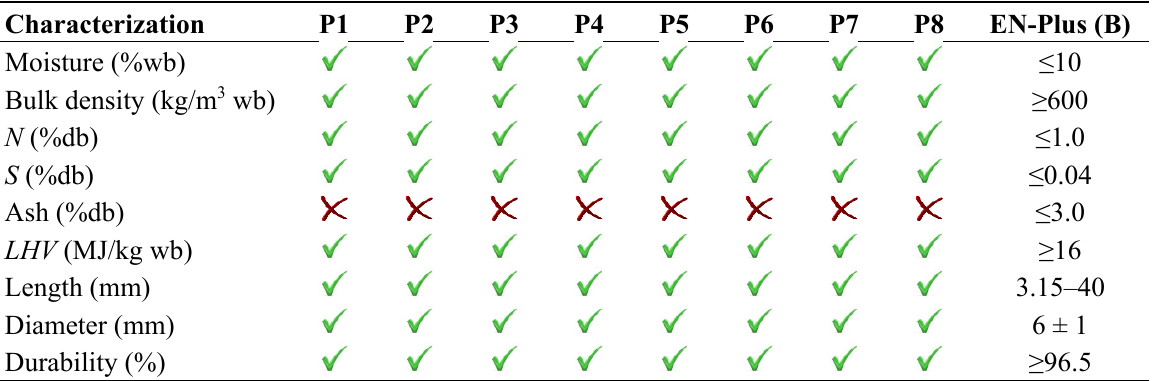
Table 6 sums up a comparison between the obtained data and the limits observed in the EN-Plus (B) norm for woody biomass for non-industrial use. Table 6. Comparison with standard EN-Plus